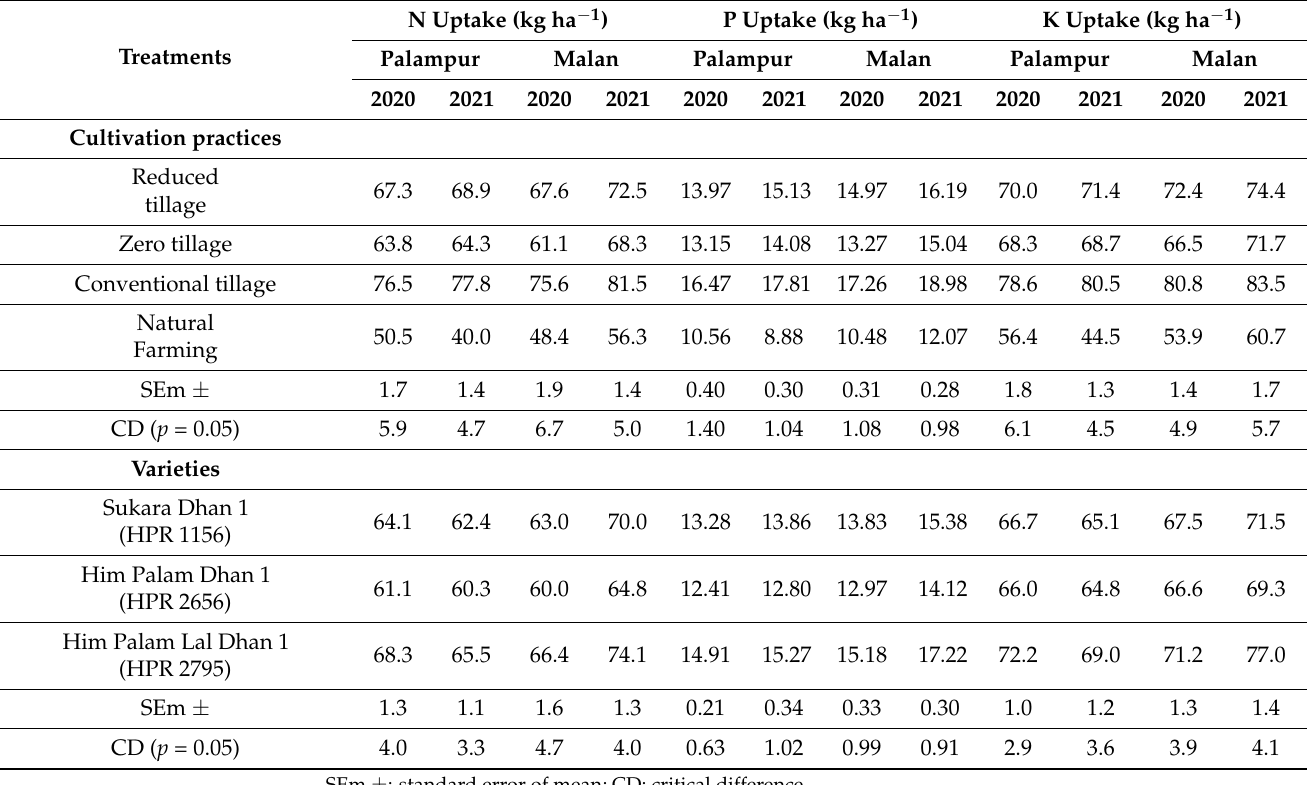
Table 6. Effect of cultivation practices on total N, P, and K uptake of different rice varieties at Palampur and